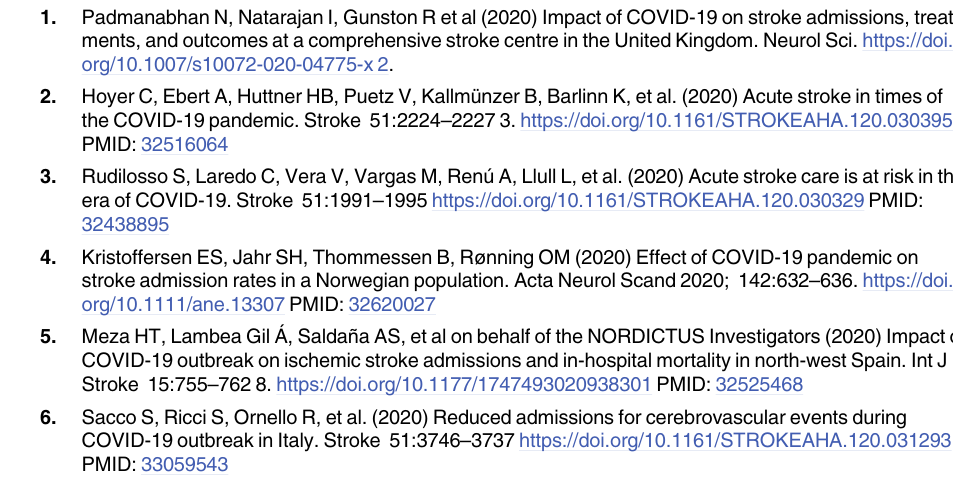
S1 Table. Baseline characteristics of study